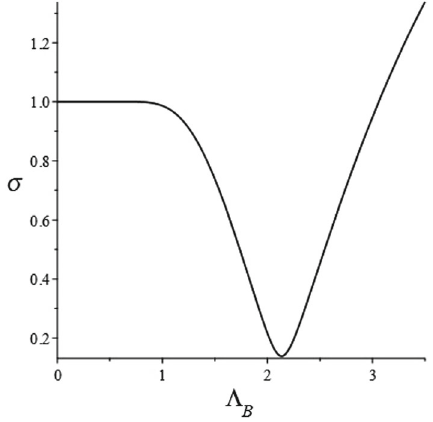
Fig. 2 Variation of standard deviation with parameter (cid:2) B Table 2 Branching ratios of nonleptonic decays of (cid:2) b → (cid:2) c Decay Ours (with Eq. 14) Ours (with Eq.